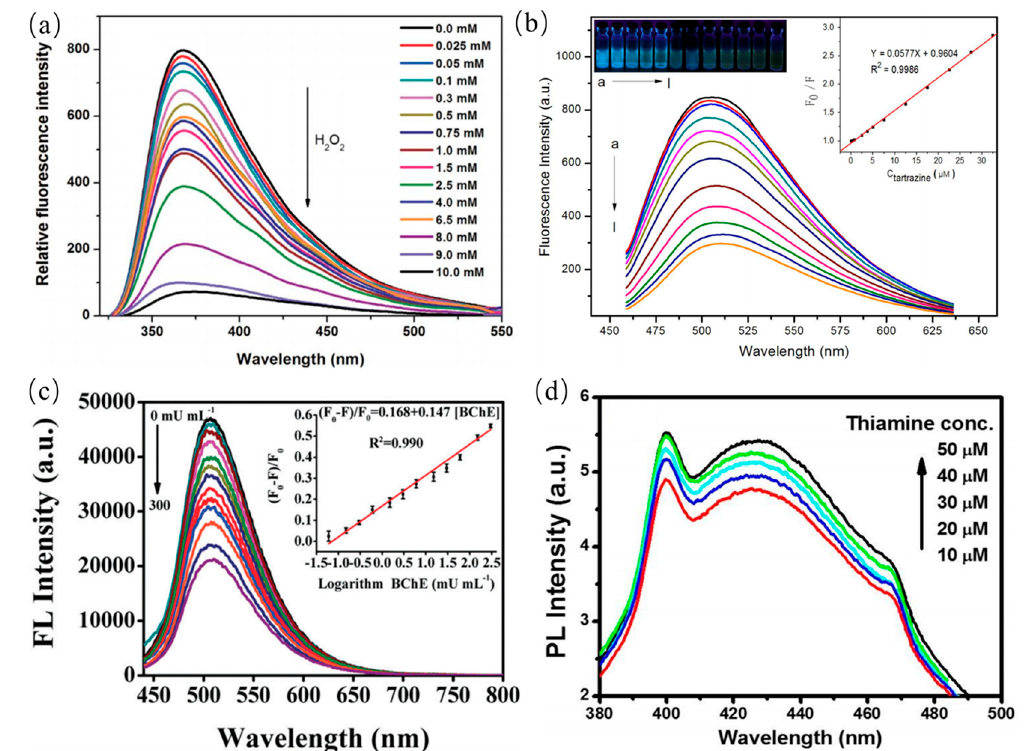
Figure 20. FL response of CDs dispersion in the presence of various molecules: ( a ) H 2 O 2 [153]. Copyright 2014, Royal Society of Chemistry. ( b ) Tartrazine [156]. Copyright 2015, American Chemical Society. ( c ) Butyryl cholinesterase